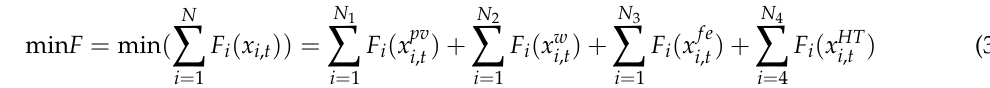
Figure 5. The prediction error of WT ( a ), the error distribution in p. u. ( b ), comparison of WT output ( c